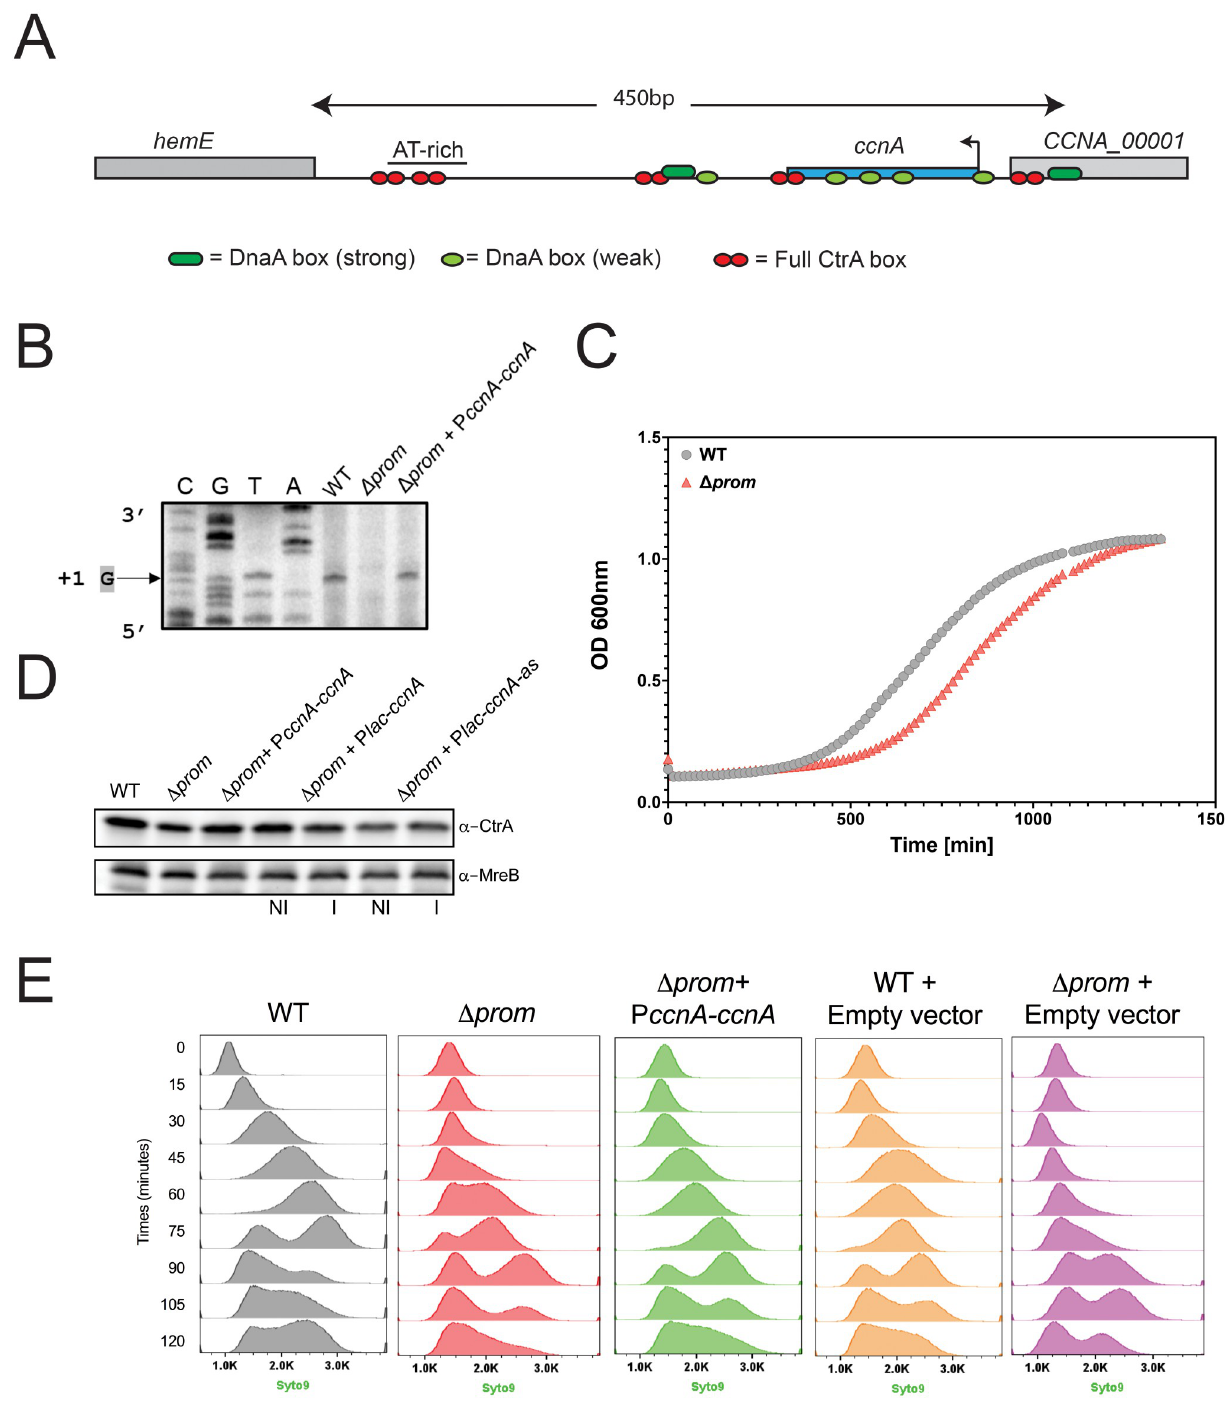
Fig 3. Δ prom cell cycle defects are rescued by CcnA in trans under the control of its own promoter. ( A) Schematic representation of the origin of replication and ccnA gene locus in C . crescentus . The origin of replication contains 5 full CtrA boxes, 2 strong and 5 weak DnaA boxes [44]. Transcription of hemE gene is important for DNA replication and can be negatively regulated by CtrA when present [44,45].The chromosome replication initiator protein DnaA unwinds the DNA from the AT Rich region on the chromosome when CtrA is absent. The ccnA gene is 182 nt long and contains 3 DnaA weak boxes, a CtrA box in its promoter region and a CtrA box in its terminal region. ( B) Determination of the transcriptional +1 site of CcnA ncRNA by primer extension . Total RNA extracted from WT cells, deleted ccnA promoter ( Δ prom ), and containing P ccnA-ccnA ( Δ prom + P ccnA-ccnA ) were used with radiolabelled oligo. The same oligo was used for ccnA sequencing (CGTA). The +1 signal is represented by the arrow. See S7A Fig for